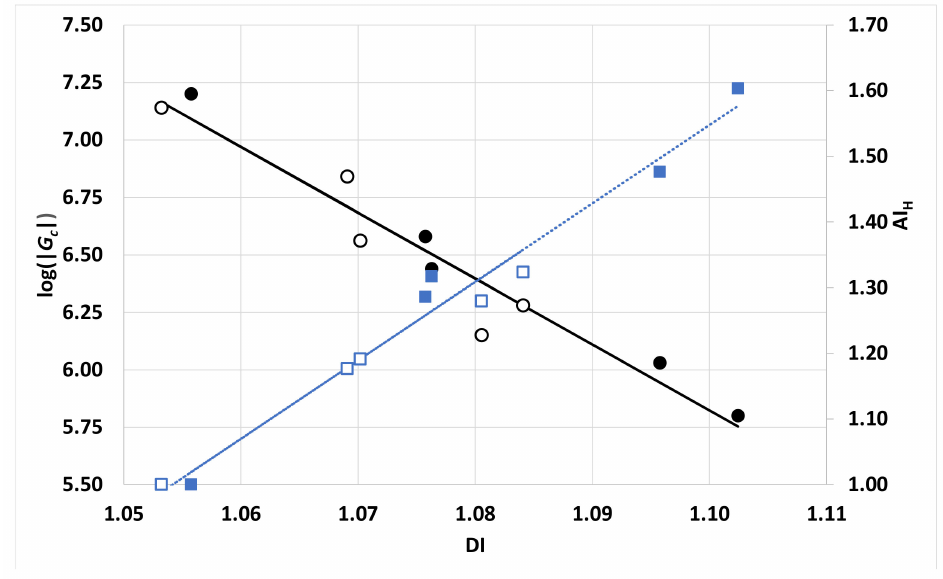
Figure 14. Correlations between the logarithm of | G c | expressed in Pa and DI for B ( • ) and LS-B ( and between AI H and DI for B ( (cid:4) ) and LS-B ( (cid:3)